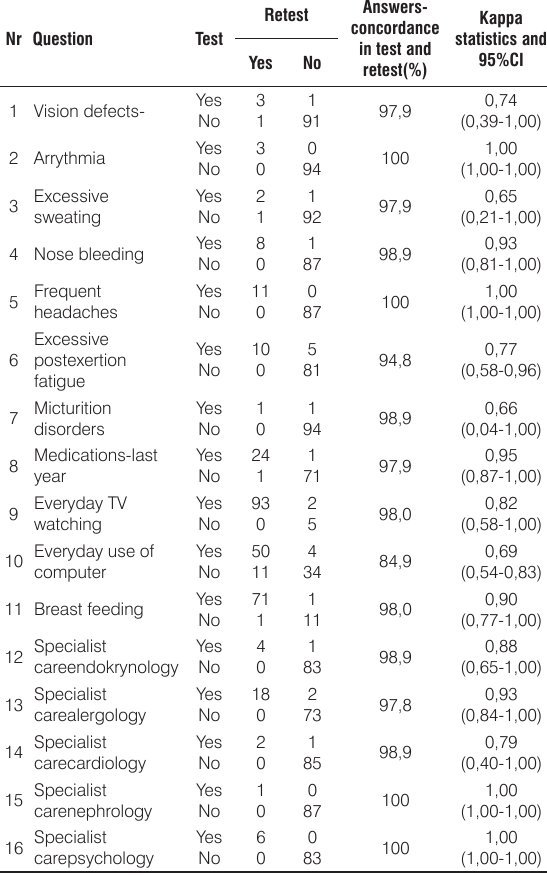
Table 2. Concordance of test and retest results for questions describing frequency of selected disorders or behaviors and specialist outpatient clinics attendance among studied